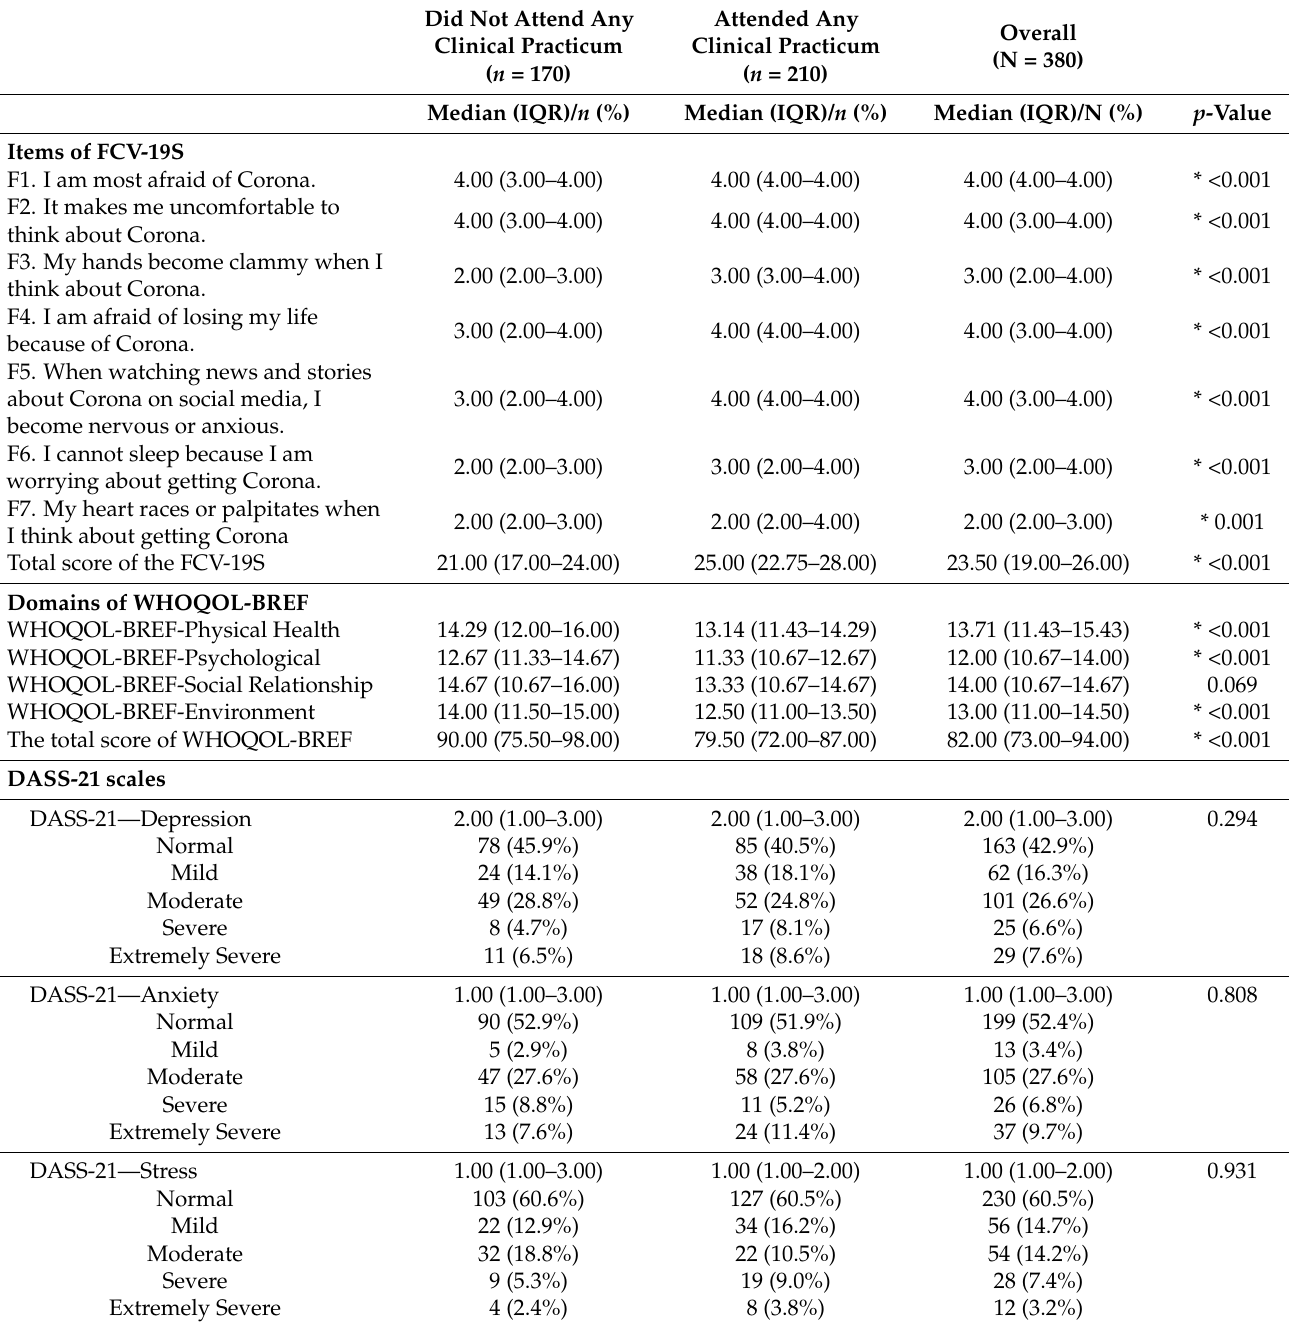
Table 2. Ratings of the FCV-19S, WHOQOL, and DASS-21 between the groups (attended and did not attend any clinical